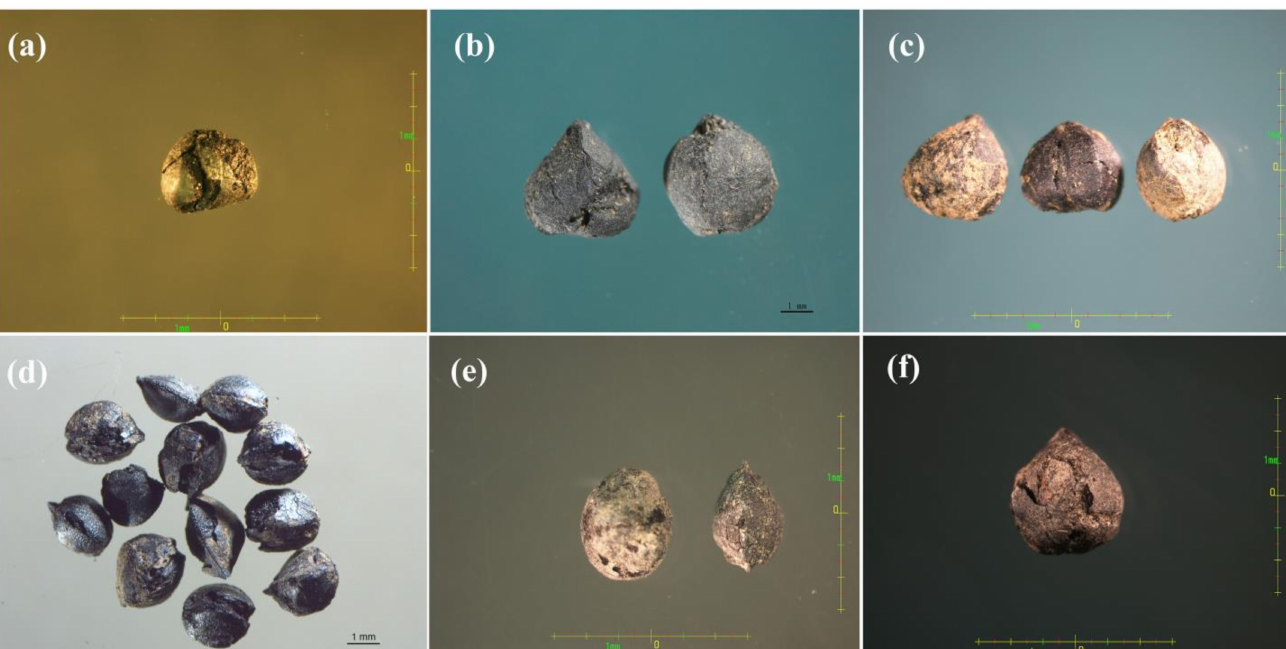
Figure 3. Buckwheat seeds found at different excavation sites from different epochs: ( a ) Chunqiu dynasty, ( b ) Han-Liao-Jin dynasty, ( c ) Han-Liao-Jin dynasty, ( d ) Song dynasty, ( e ) Liao dynasty, and ( f ) Liao-Jin dynasty.